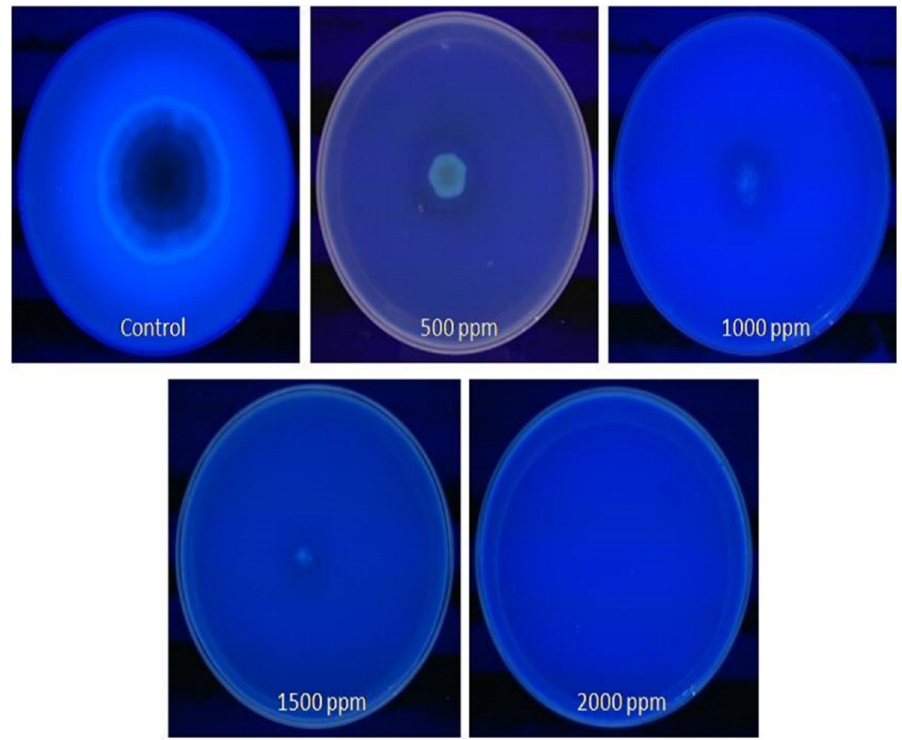
Figure 5. Detection of aflatoxin (AFB1) production by A. flavus treated with clove essential oil on CMA observed under UV radiations.